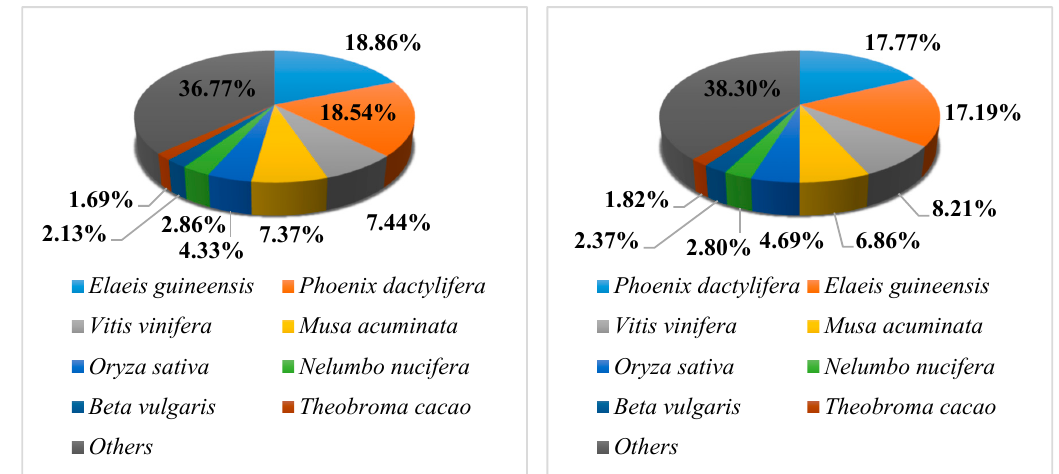
Figure 3. Species distribution of non-redundant (NR) annotation results of the L. radiata unigenes. Left, Replicate 1; Right, Replicate 2.